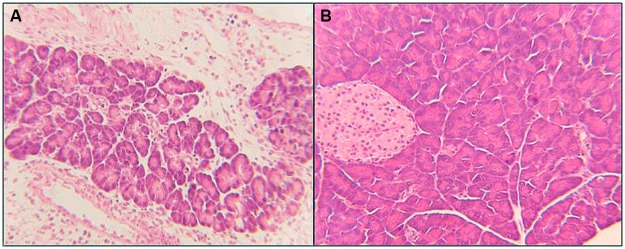
Pancreatic section from Toxoplasma infected and treated dams stained with H&E. (A) Pancreatitis: demonstrates loss of microstructure, degeneration, and necrosis of pancreatic cells, degeneration and loss of islets, replaced with infiltration of inflammatory cells. (B) Combination diclazuirl plus atovaquone (Dic + Atov) therapy protected pancreatic architecture against inflammatory and infectious response, and preserved panc and beta cells, and islet’s microstructure. (n = 6–8/group).